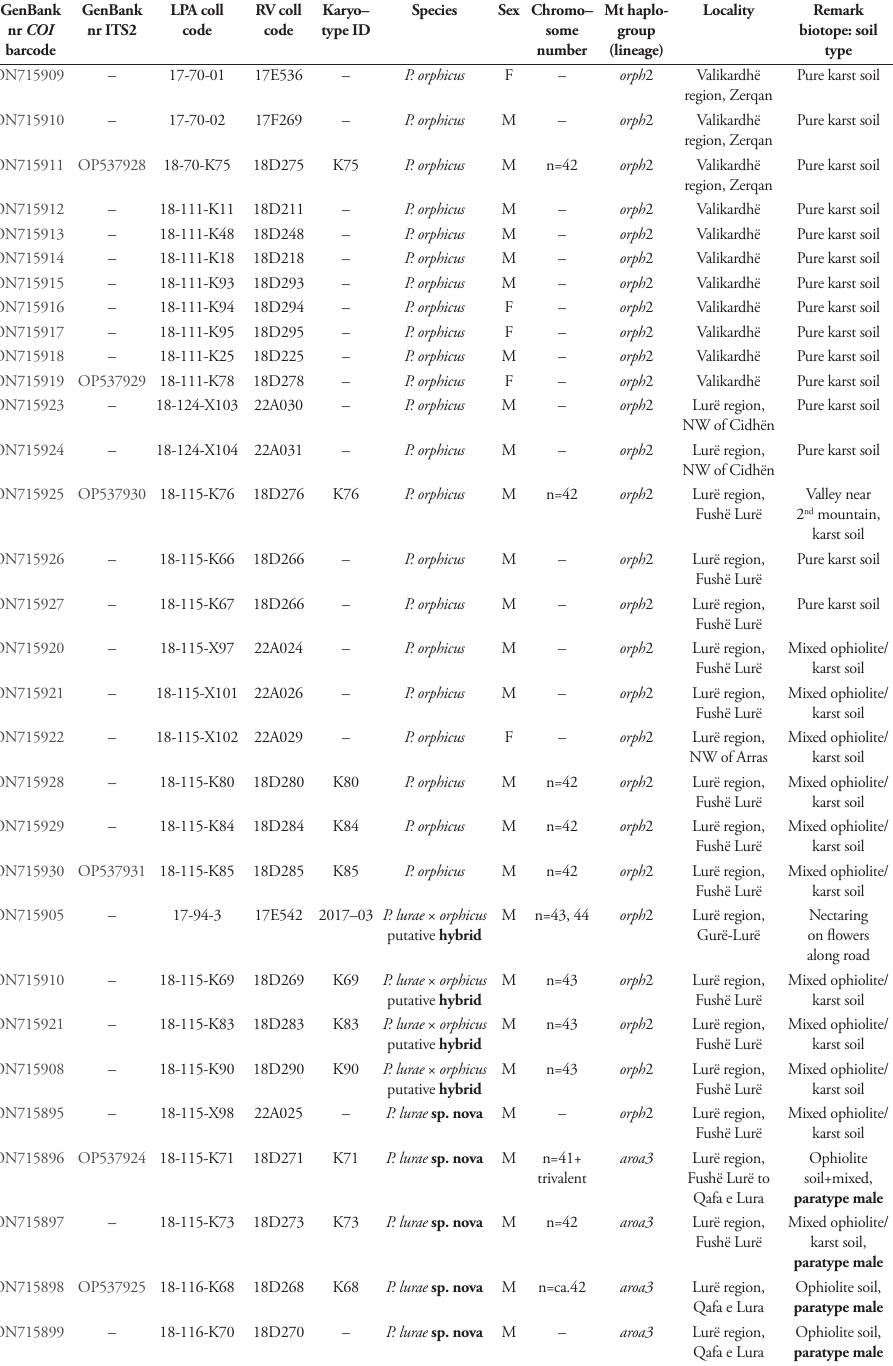
Table 1. List of the studied samples of brown Polyommatus ( Agrodiaetus ) from Albania. GenBank nr COI